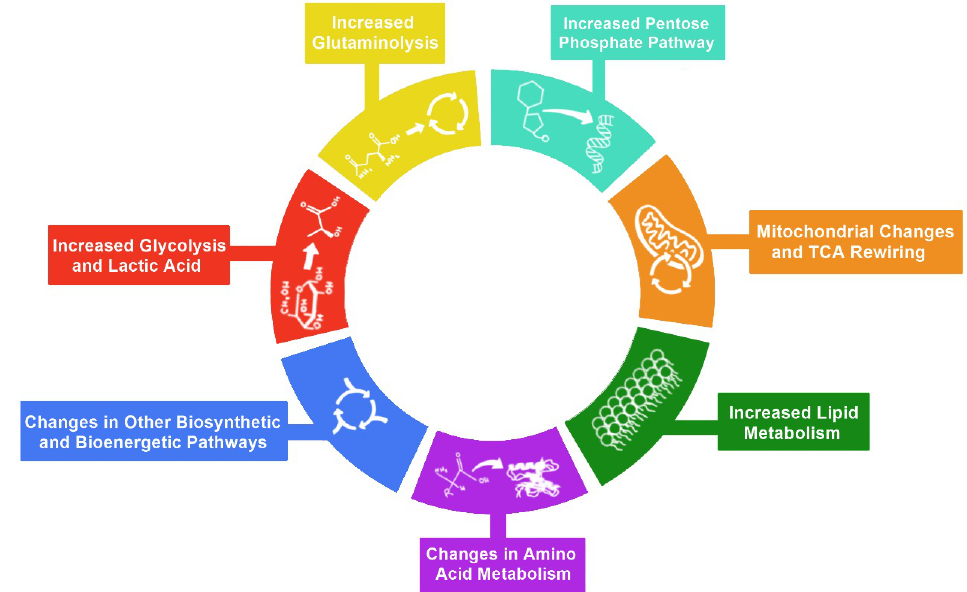
Figure 1. Hallmarks of metabolic reprogramming. The illustration represents the seven hallmarks of metabolic reprogramming: 1—increased glycolysis, 2—increased glutaminolysis, 3—increased pentose phosphate pathway, 4—mitochondrial changes and TCA rewiring, 5—increased lipid metabolism, 6—changes in amino acid metabolism, and 7—changes in other biosynthetic and bioenergetic